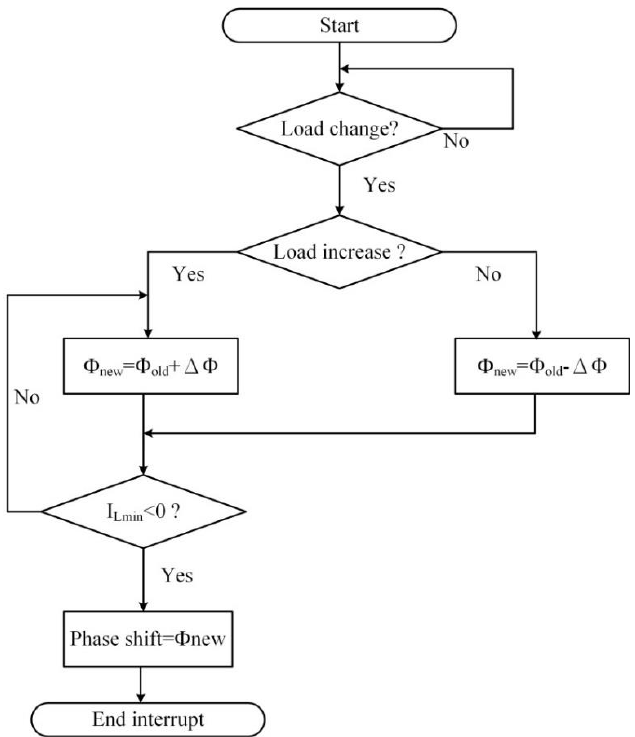
Figure 8. Flowchart of the proposed APS method.